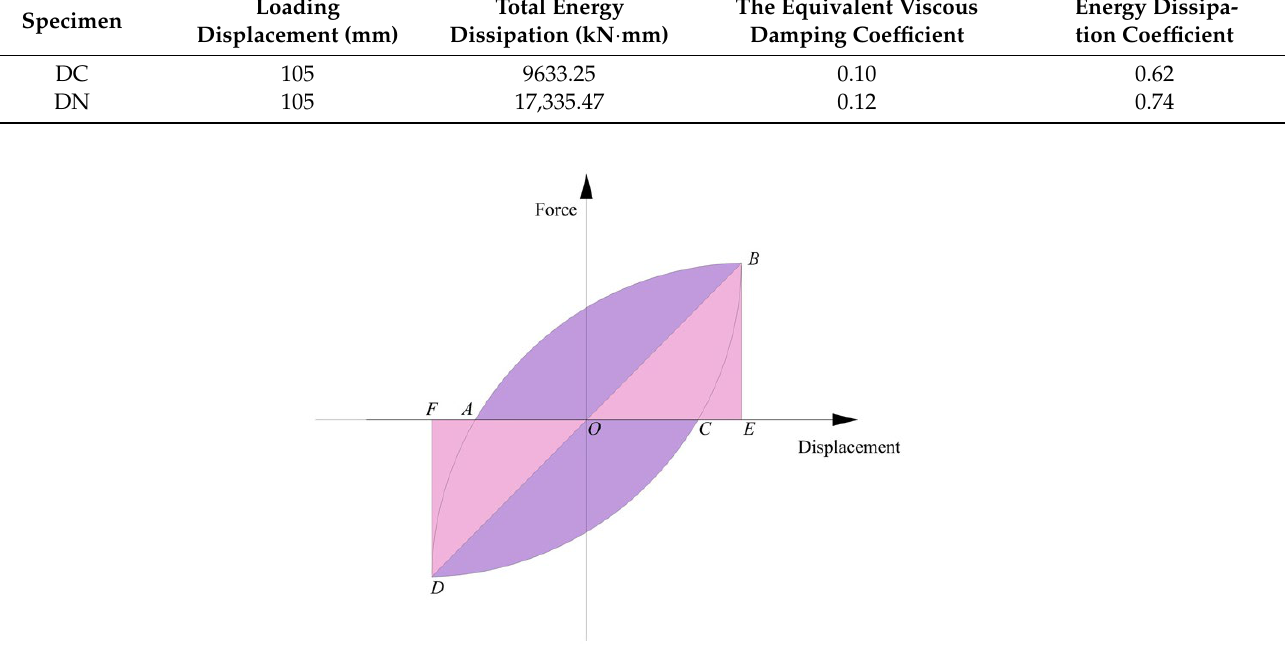
Table 5. Parameters of energy dissipation.